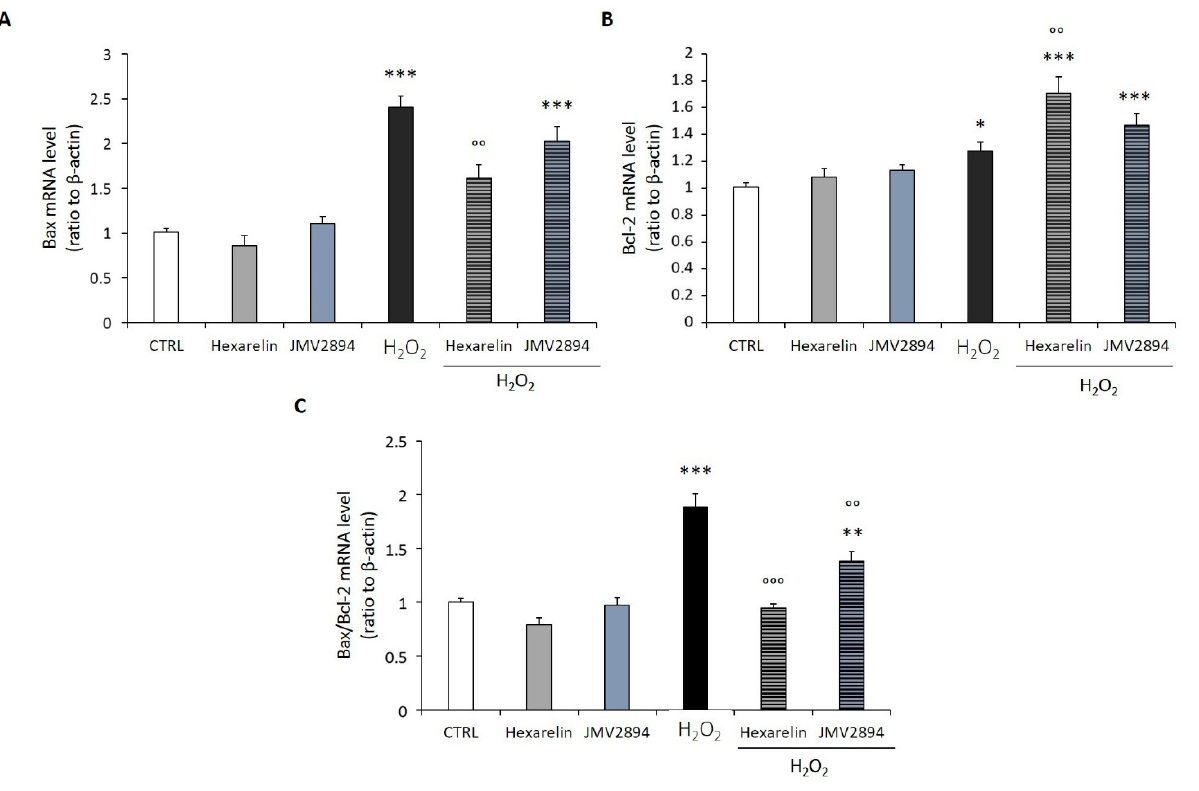
Figure 6. Quantification of mRNA levels of apoptosis markers following H 2 O 2 and GHS exposure. The SH-SY5Y SOD1 G93A cells were plated at a density of 200,000 cells/well in 24-well plates and treated with H 2 O 2 , GHS alone, or co-incubated with GHS 1 µM and H 2 O 2 150 µM for 24 h. After treatment, the mRNA expression of Bax ( A ) and Bcl-2 ( B ) was assessed by Real-Time PCR using β -actin as house-keeping gene. ( C ) Quantification of Bax/Bcl-2 ratio. Data are expressed as mean ± SEM of 18 replicates obtained in 3 independent experiments (n = 6 in each experiment). * p < 0.05, ** p < 0.01, *** p < 0.001 vs. CTRL; °° p < 0.01, °°° p < 0.001 vs. H 2 O 2 .